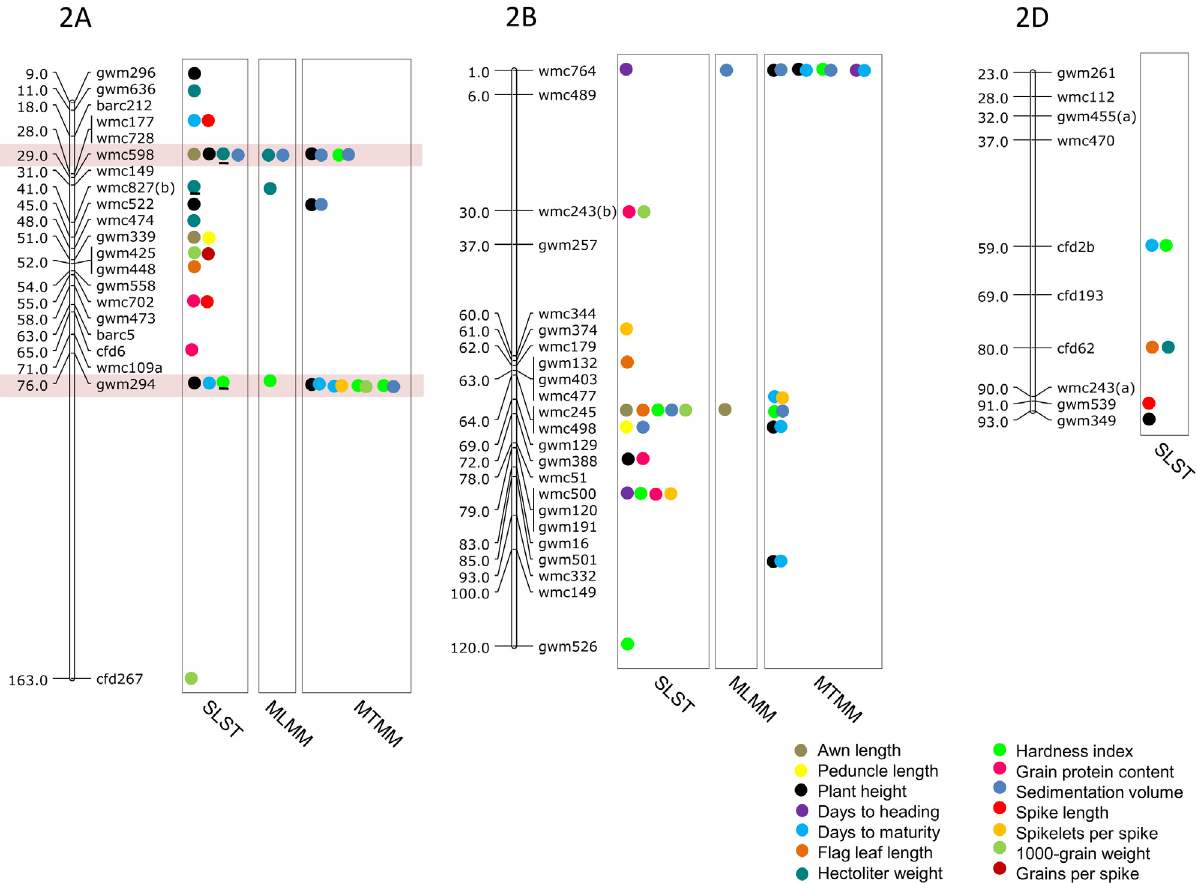
Fig 4. SSR genetic linkage maps of homoeologous group 2 chromosomes showing markers-trait associations (markers associated with different traits are shown by solid circles with different colours), black bar given below the solid circle represents that MTA qualified FDR criterion; markers are indicated to the right and map distances (cM) are indicated to the left of the vertical bar (based on the consensus linkage map of Somers et al. [76]). MTAs identified through all three approaches (SLST, MLMM and MTMM) are highlighted with